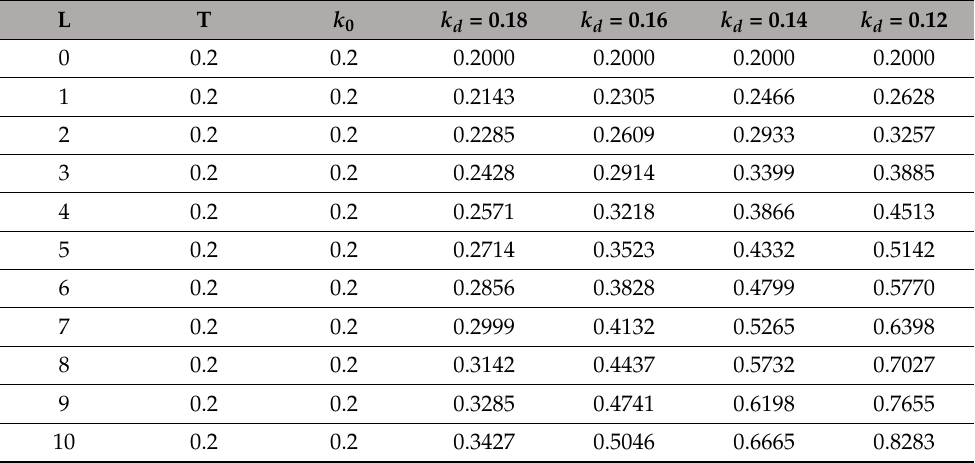
Table A10. Dependence of the equity cost, k e , on leverage level L at p = 2 and fixed k d = 0.18